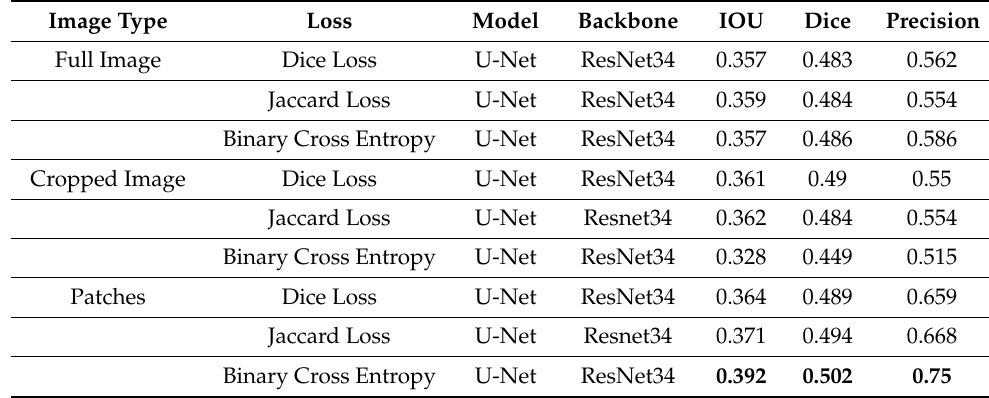
Table 3. Training and testing on B-Scans using (3) image types and (3) loss functions.